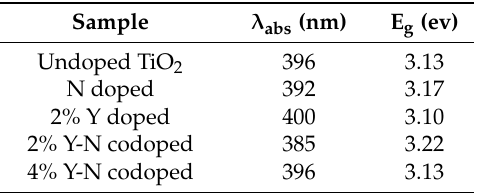
Figure 5. ( a ) ground-state diffuse reflectance absorption spectra of undoped, doped and codoped TiO 2 with N and Y, annealed at 400 °C; ( b ) Tauc plots of pure and N-doped TiO 2 samples, evidencing the calculation of the band gap energies for these two samples. Table 1. Energy gaps and λ abs for TiO 2 undoped, doped and codoped with N and Y.